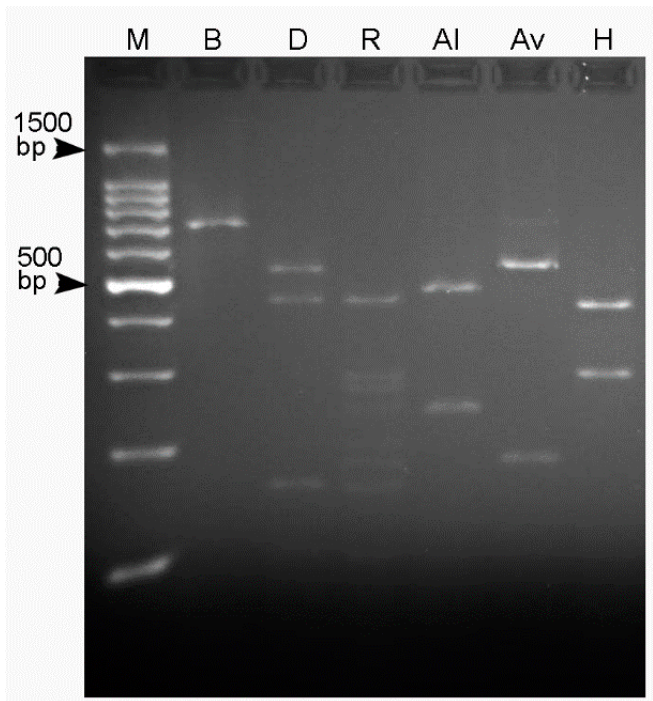
Figure 1. Restriction fragments of an amplified ITS of Pratylenchus vovlasi sp. nov. Al: Alu I, Av: Ava II, B: Bam HI, D: Dde I, H: Hinf I, R: Rsa I and M: 100 bp ladder.